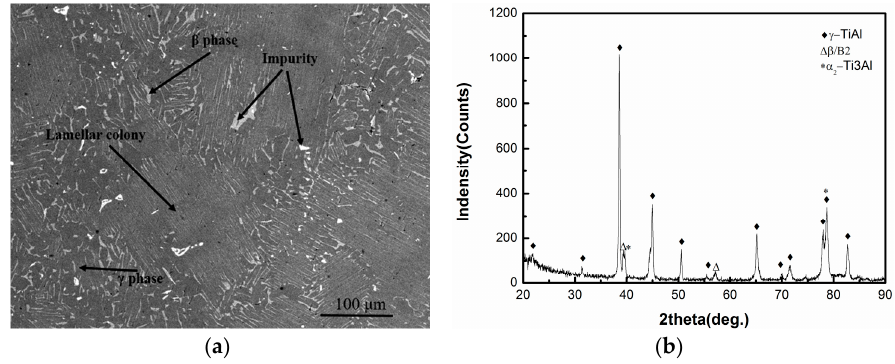
Figure 1. ( a ) The initial microstructure; and ( b ) X ‐ ray diffraction pattern of HIPed